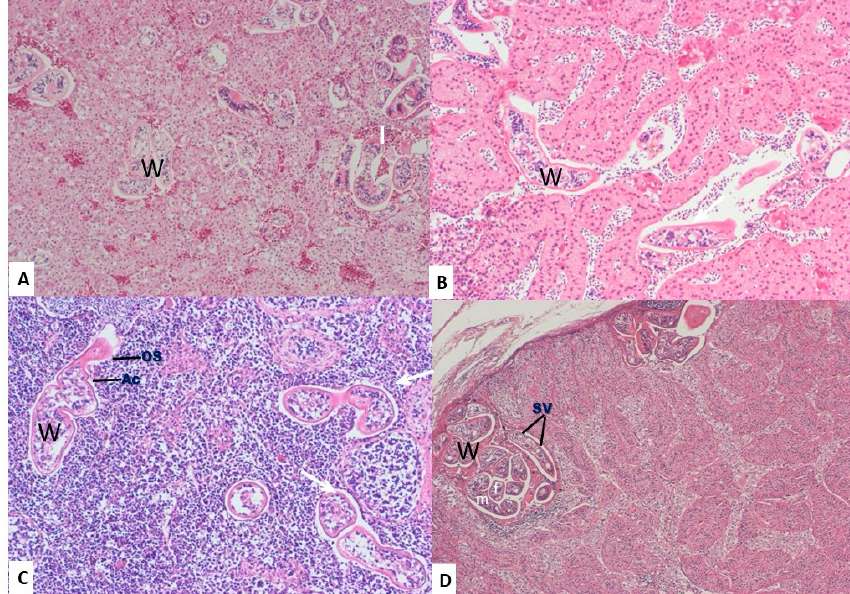
Figure 3. Effect of the parasite in the adrenal gland, spleen, and testis. ( A , B ) Multiple cross-sections of adult worms (W) found in the sinusoids of the adrenal gland surrounded by infiltration of mononuclear inflammatory cells (I). ( C ) Adult worms (W) found in the splenic veins. Note the oral sucker (Os) and acetabulum (Ac) of the parasite. ( D ) Multiple cross-sections of adult schistosomes (W) completely occlude the subcapsular veins of the testis and were surrounded by the infiltration of mononuclear inflammatory cells (I). Note the seminal vesicles of the parasite (Sv) and the presence of female (f) in the ventral groove of the male (m) parasite. Hematoxylin and eosin stain (100×).